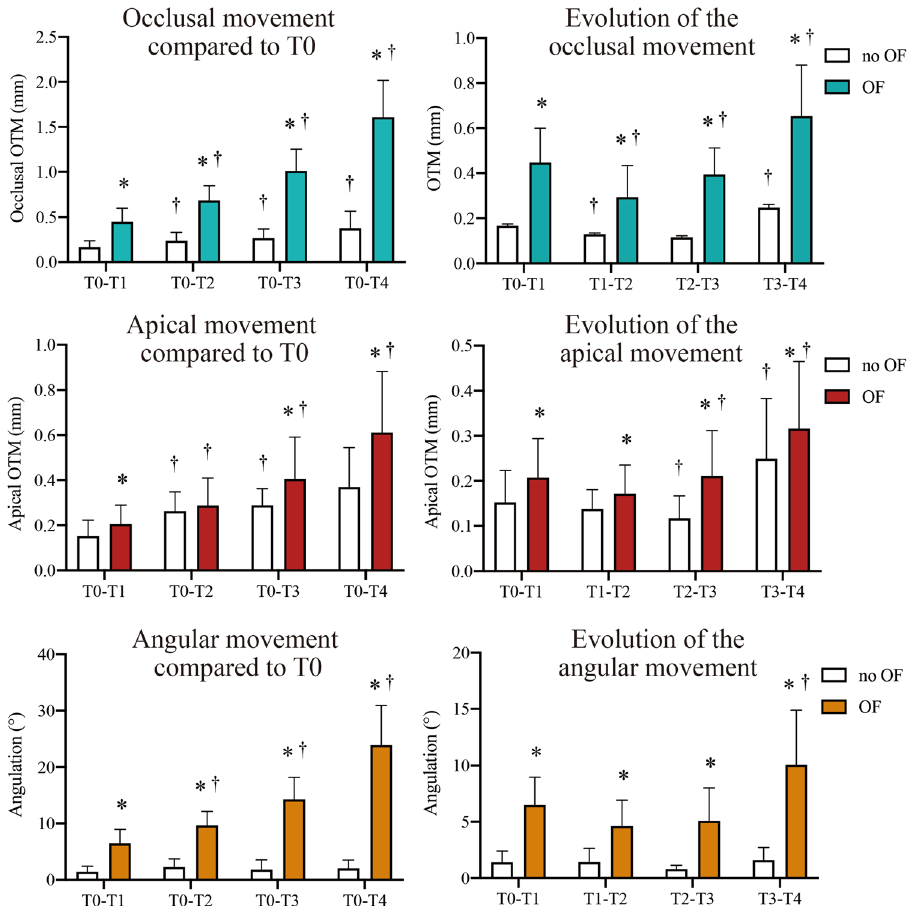
Figure 4. First molar displacement. The OTM was compared between different time points (T0–T4) and between the OF and no OF side by two-way repeated measures MANOVA and post-hoc Tukey’s test (n = 12). * P < 0.01 versus no OF side. † P < 0.01 versus previous